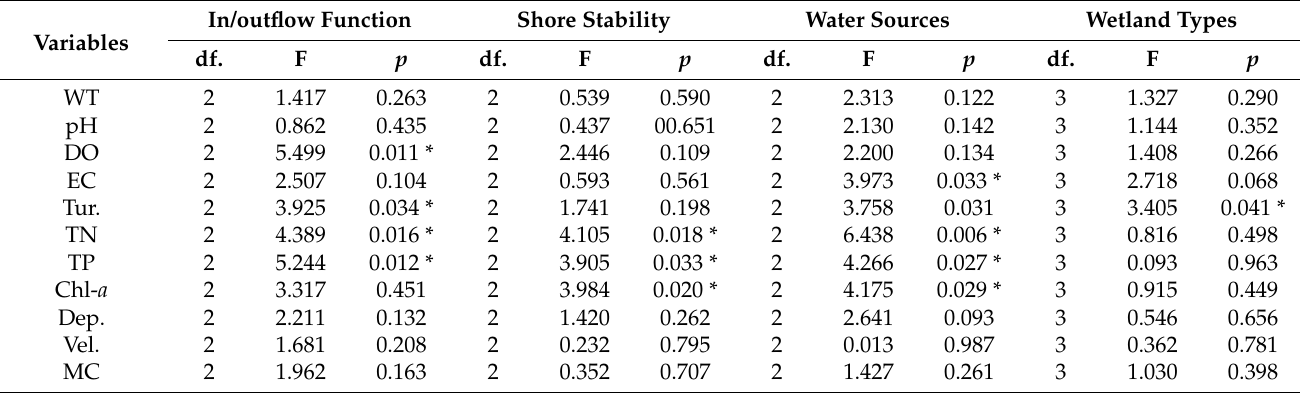
Table 3. Results of factorial MANOVA comparing the effects of four hydrological factors on environ- mental variables: WT, water temperature; DO, dissolved oxygen; EC, conductivity; Tur., turbidity; TN, total nitrogen; TP, total phosphorus; Chl- a , chlorophyll a . Dep., depth; Vel., velocity; MC, macrophyte coverage. The mark (*) indicates a statistically significant value.